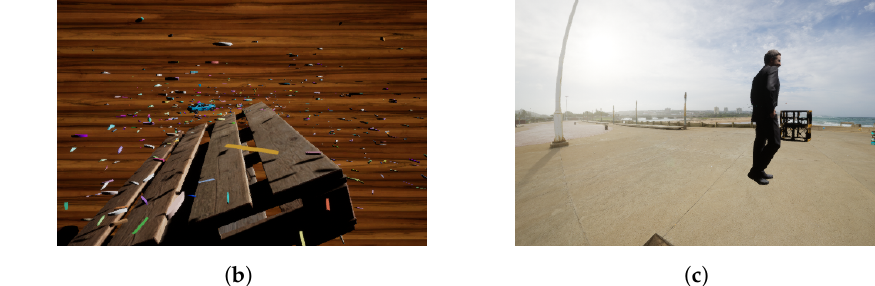
Figure 5. Example of data generated in UE4: ( a ) HDRI and distractors; ( b ) randomized environment with distractors; ( c ) HDRI with no